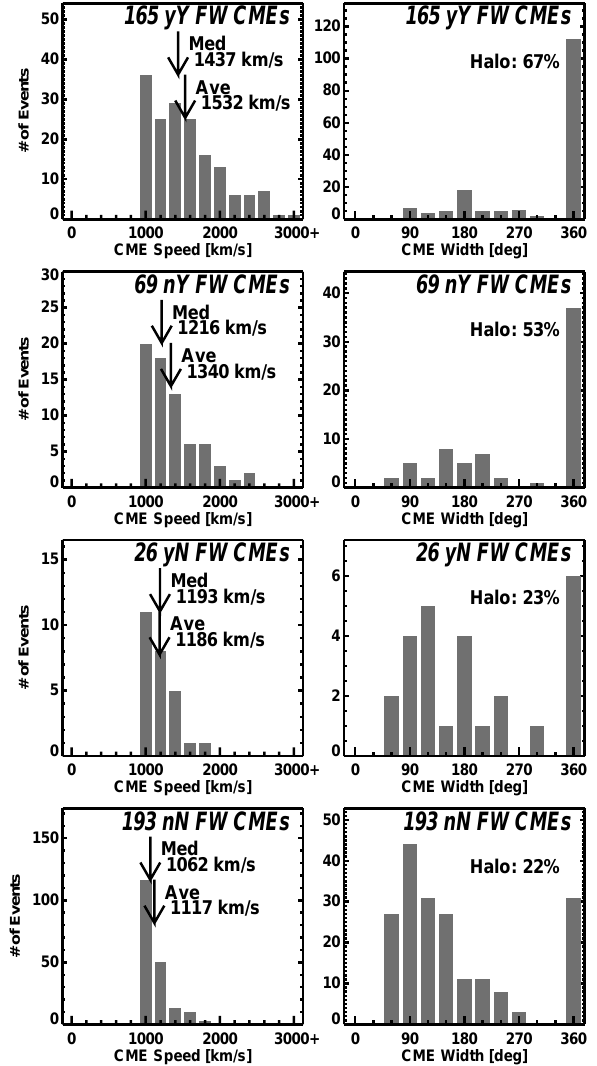
Fig. 2. Speed (left) and width (right) distributions of RQ (bottom row) and RL (3 upper rows) FW CMEs. Presence of type II radio bursts is indicated by y & Y (for yes) in metric and DH wavelengths, respectively; similarly, absence is indicated by n & N (for no). Thus nN events are RQ CMEs, while yY, nY, and yN represent RL CMEs. Note that 11 RL FW CMEs are not included because of data gap in one of the radio bands (metric or DH). The speed bins have a size of 200km/s, containing CMEs with speeds within ± 100km/s of the bin value. For example, the 1000km/s bin contains CMEs with speeds ≥ 900km/s but < 1100km/s. For the width distribution, the bin size is 30 ◦ and each bin contains CMEs within ± 15 ◦ centered on the bin